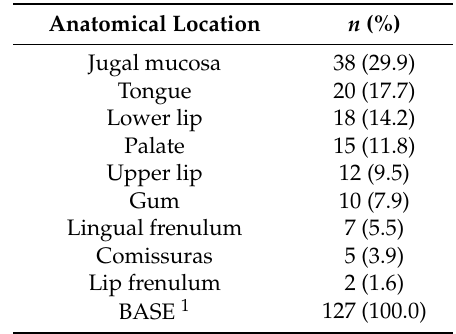
Table 3. Distribution of patients according to the OM sites.